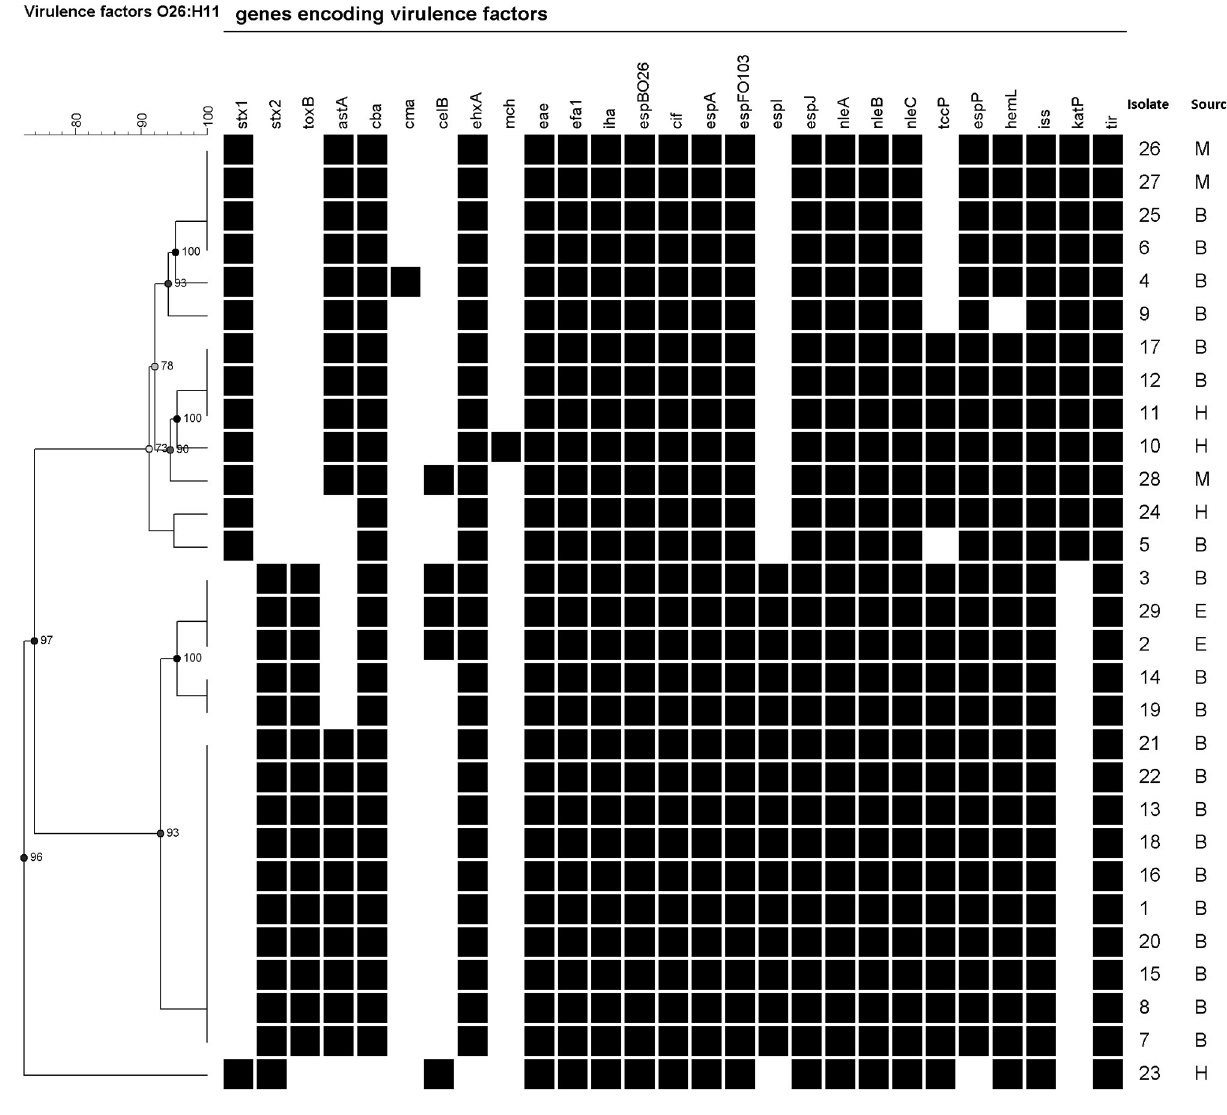
FIGURE 1 | Cluster analysis of genes associated with virulence. B, E, H, andM indicate isolates obtained from bovine, environmental, human, and meat sources, respectively. Results for the lpf gene are not included because of the ambiguous signal observed for all strains. Genes not found in the any of the studied strains: bfp A, ccl , cdt B, cfa C, cnf 1, cof A, eaa A, eat A, epe A, esp A_C_rodentium, esp B_O157, esp C, esp F, esp F_C_rodentium, etp D, fan A, fas A, fed A, fed F, f17-A, f17-G, fim 41a, hly E, ipa D, ipa H, ire A, iro N, K88ab, lng A ltc A, nfa E, nle B O157:H7, nle B Salmonella, per A, pet , pic, prf B, rpe A, saa , sat , sen B, sep A, sfa S, sig A, sta 1, sta 2, stb , stx 2b , stx 2c , stx 2d , stx 2e , stx 2f , stx 2g , sub A, tsh , vat, vir